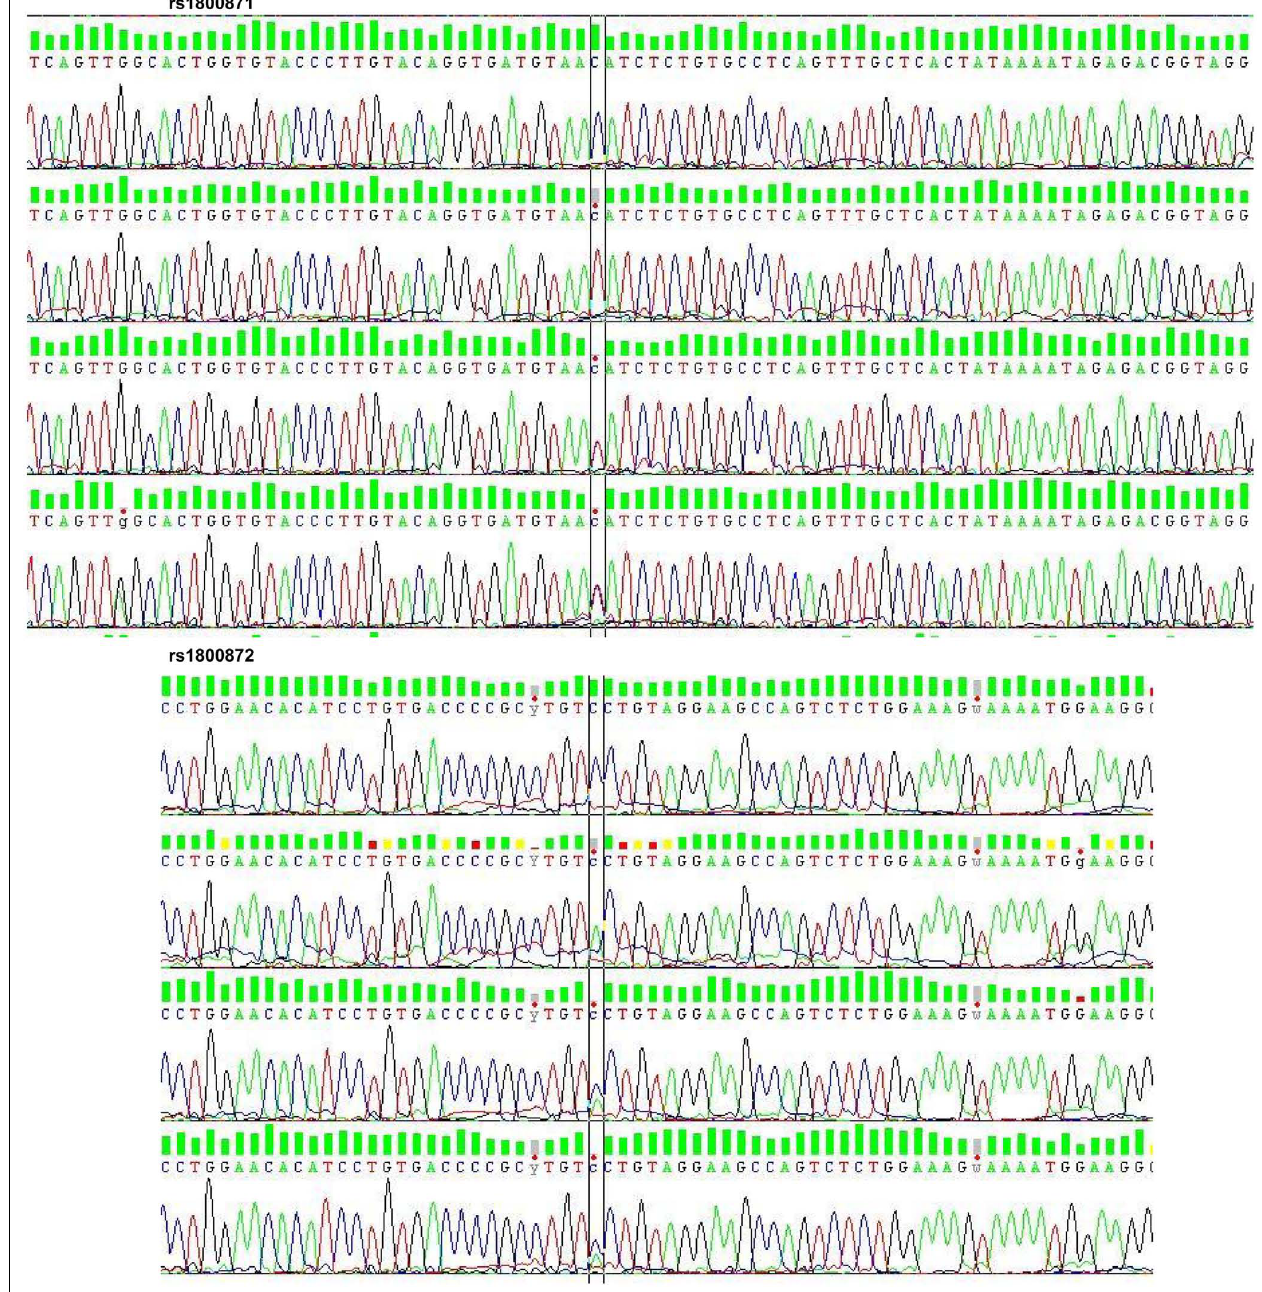
FIGURE 1 | Electropherogram of rs1800871 and rs1800872 . rs, reference SNP; SNP, single nucleotide